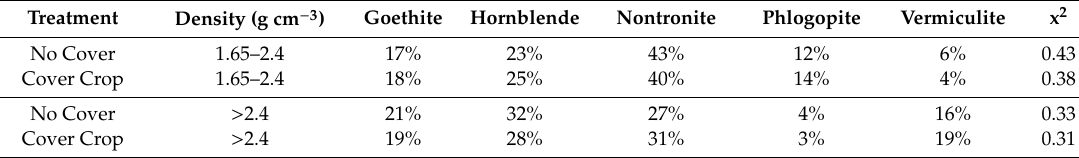
Figure 4. Fe K-edge k 3 weighted EXAFS spectra of intermediate (1.65–2.4 g/mL − 1 ) and heavy (>2.4 g/mL − 1 ) soil density fractions from no cover (blue lines) and cover crop (red lines) treatments. Grey dashed lines indicate the least squares best fit for each sample (see Table 3 for fit results). Table 3. Fe EXAFS linear combination fit results.